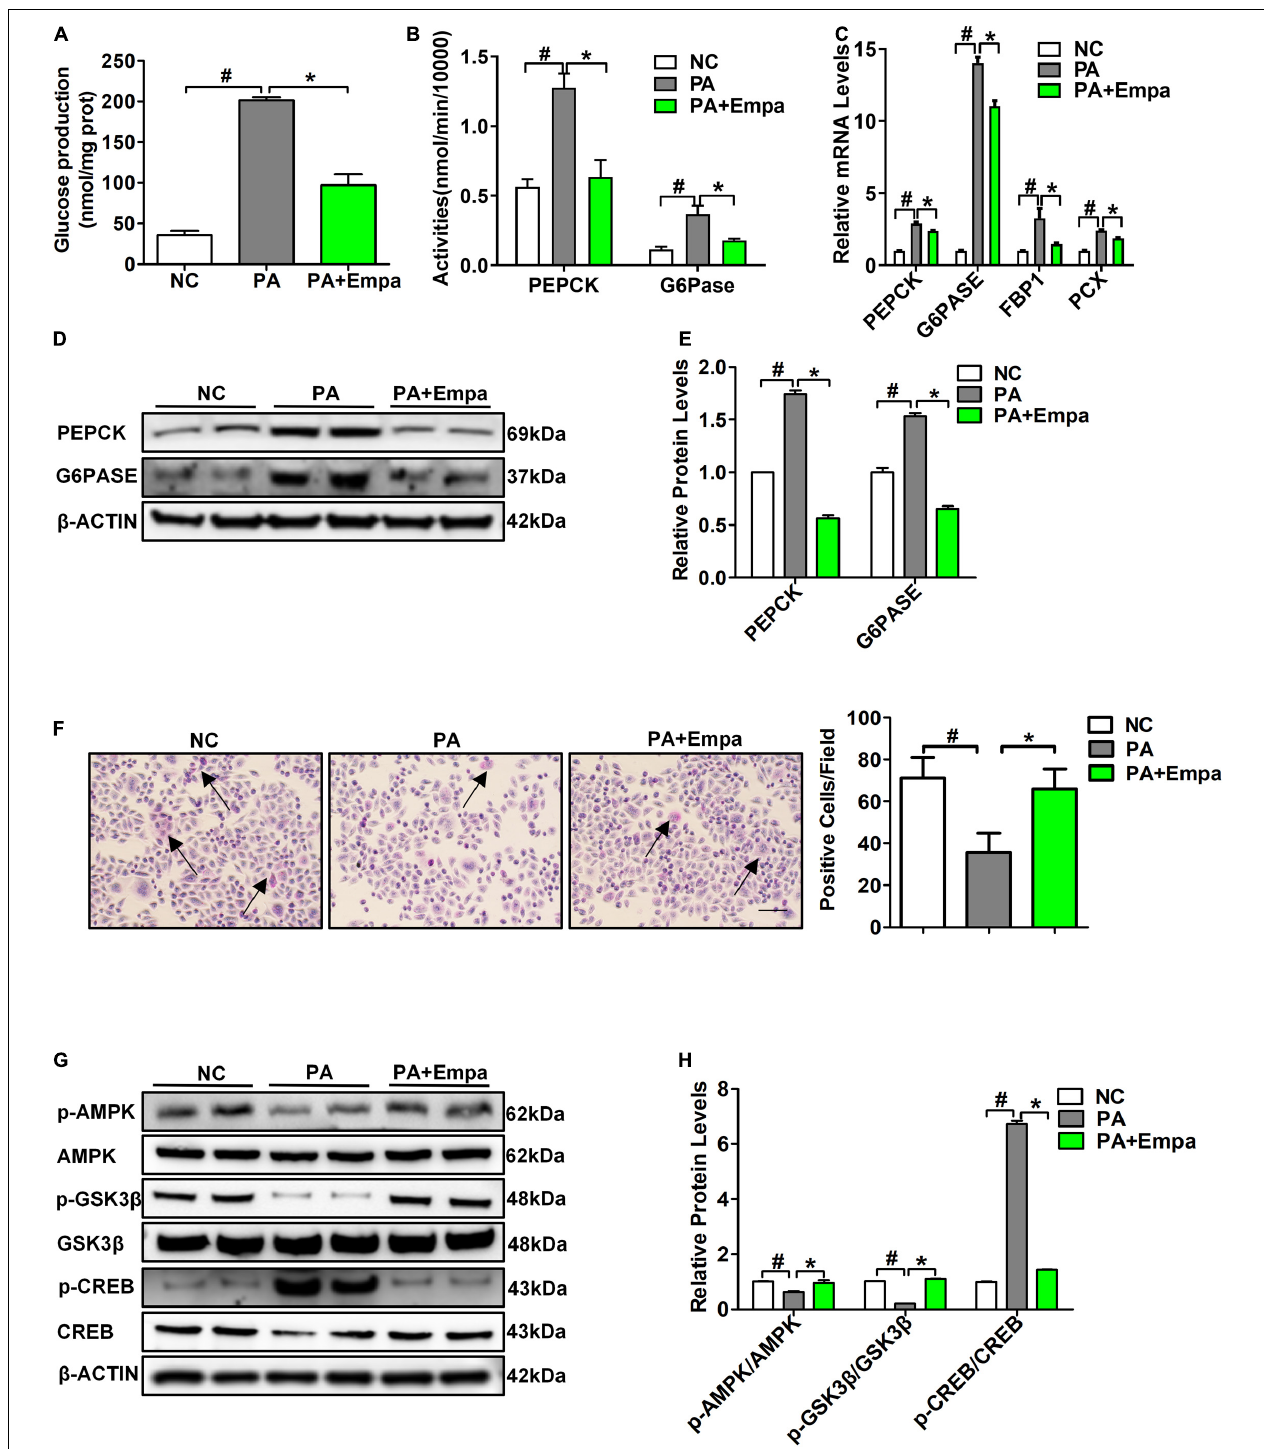
FIGURE 3 | Empagliflozin inhibited gluconeogenesis and promoted glycogen synthesis in HL7702 cells. (A) Glucose production levels ( n = 3 samples/group). (B) PEPCK and G6Pase activities ( n = 3 samples/group). (C) Relative mRNA expression levels of PEPCK, G6PASE, FBP1, and PCX were measured by RT-PCR ( n = 3 samples/group). (D) Relative protein expression levels of PEPCK and G6PASE were determined by western blotting ( n = 3 samples/group). (E) Protein quantitative statistics ( n = 3 samples/group). (F) PAS staining, scale bar = 100 µ m ( n = 6 samples/group). (G) Relative protein expression levels of p-AMPK, AMPK, p-GSK3 β , GSK3 β , p-CREB, and CREB were determined by western blotting. (H) Protein quantitative statistics ( n = 3 samples/group). * P < 0.05, PA vs. PA+Empa; # P < 0.05, NC vs. PA. Arrows indicate the areas of focus for PAS staining.